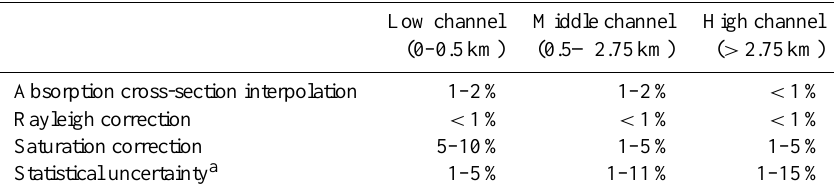
Figure 8. The left panel compares the final retrieved ozone concentration from the previous TROPOZ retrieval and the optimized retrieval (TROPOZ opt ) to the known ozone profile used in the simulated lidar return signal. The center panel shows the differences in percentage from the known profile and retrieved TROPOZ and TROPOZ opt profiles. The right panel shows the improvement from the optimized TROPOZ opt retrieval and the original TROPOZ retrieval in percentage. The mean improvement (red line) is 3.5%. Table 1. Summary of the improvements associated with the optimized GSFC TROPOZ DIAL algorithm as compared to the initial algorithm in Sullivan et al.